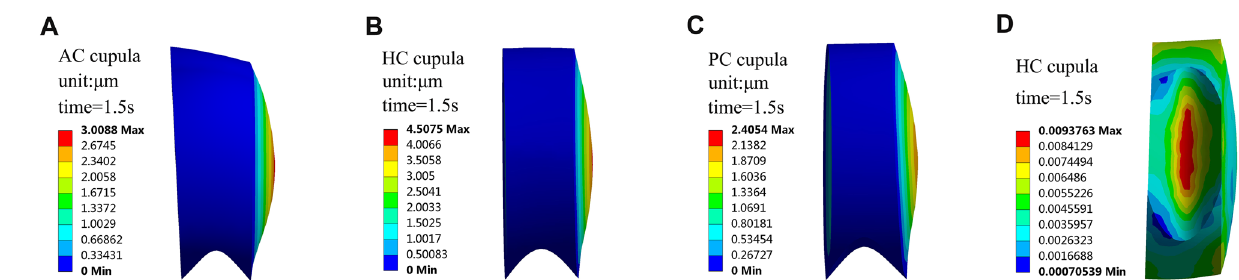
Figure 5. Cupula responses at time = 1.5 s. ( A ) The cupula deformation in AC at 1.5 s. ( B ) The cupula deformation in HC at 1.5 s. (C) The cupula deformation in PC at 1.5 s. ( D ) The cupula shear strain in HC at 1.5